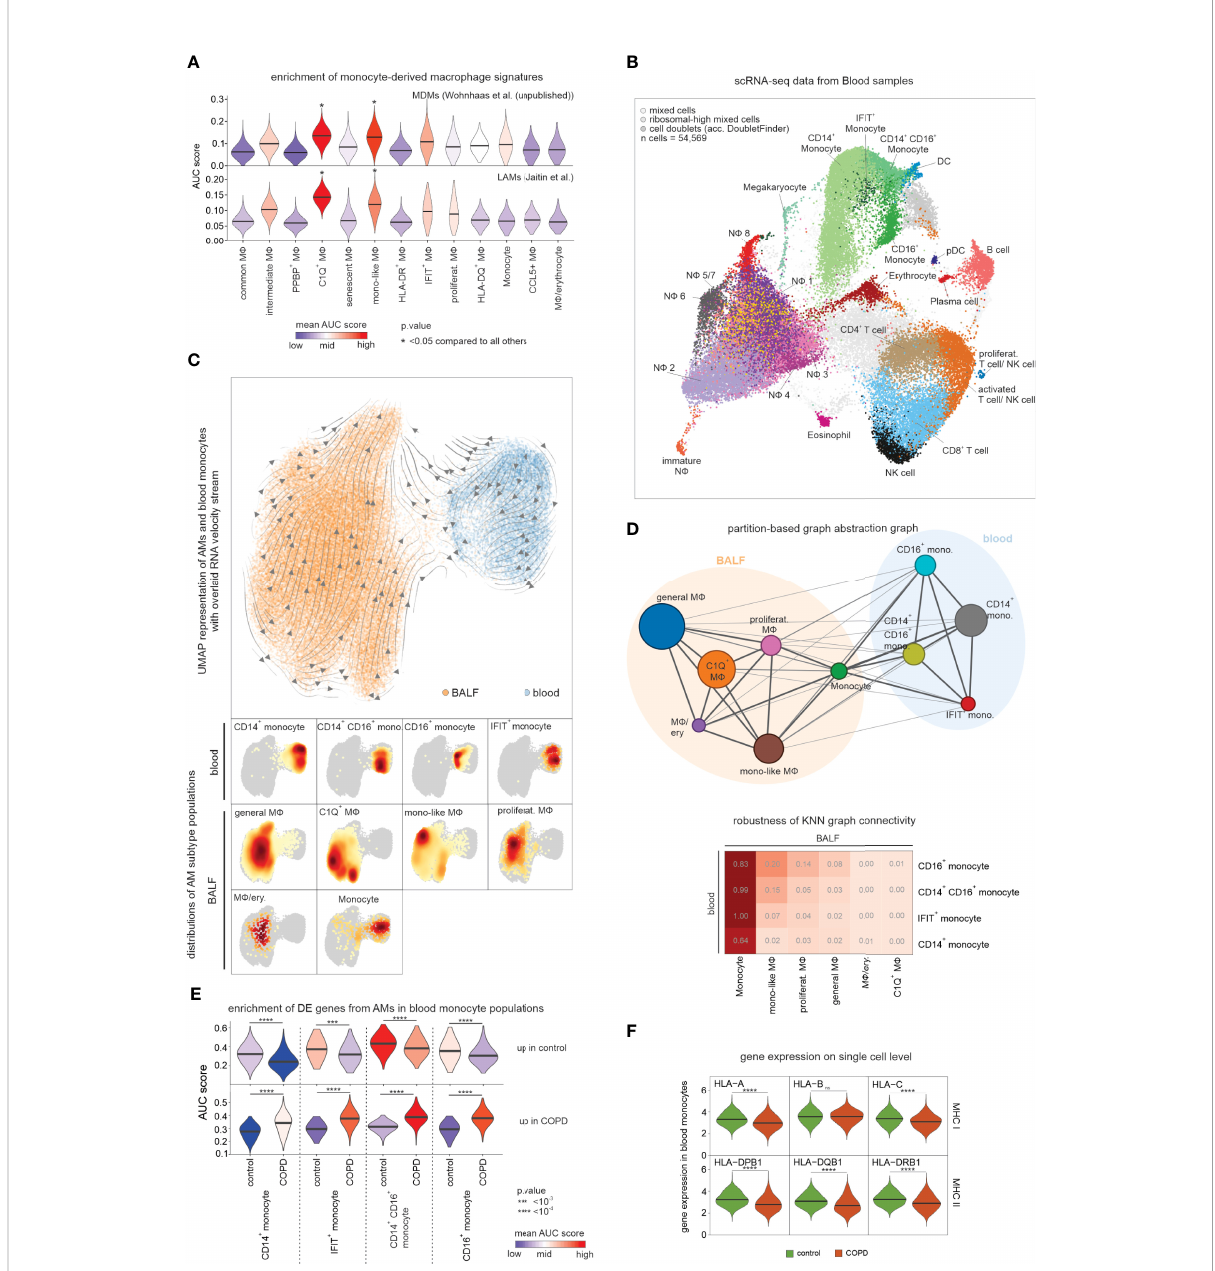
FIGURE 6 Assessing the relationship between blood monocytes and BALF macrophages. (A) Violin plots (with marked median values) displaying enrichment of human orthologues of murine monocyte-derived macrophage signature genes across macrophage states in COPD and control based on Area Under the Curve (AUC). (B) Integrated scRNA-seq data of blood immune cells annotated according to the four-step annotation approach (according to Figure 1B). (C) UMAP of embedded macrophages/monocytes from BALF and blood monocytes. Inferred main average vector fl ow is indicated by velocity streamlines that are projected as vectors. Locations of the main cell types (acc. to the combined labels from Figure S6A) in the UMAP are indicated by the heat maps at the bottom. (D) PAGA graph derived from embedded BALF and blood data (according to Figure 6C). The weight of an edge, which re fl ects a statistical measure of connectivity, is represented as the edge width. The table below summarizes the results of the PAGA connectivity calculation, where a value of 1 indicates a strong connection and 0 indicates a weak connection between two cell types. (E) Violin plots (with marked median values) displaying enrichment of macrophage-related DE genes (according to Figures 4B, C) in blood monocytes based on AUC. (F) Violin plots with marked median of the expression of HLA genes, in blood monocytes based on scRNA-seq data. The plots show the expression across the donors, whereby the donors were downsampled to the same number of cells, followed by downsampling to the same number of cells between COPD and control. The plots display cells with an expression > 0. BALF, bronchoalveolar lavage fl uid; mono, monocyte; M Ф , macrophage; N Ф , neutrophil; proliferat., proliferating; MDM, monocyte-derived macrophage; LAM, lipid-associated macrophage; ns, means not signi fi